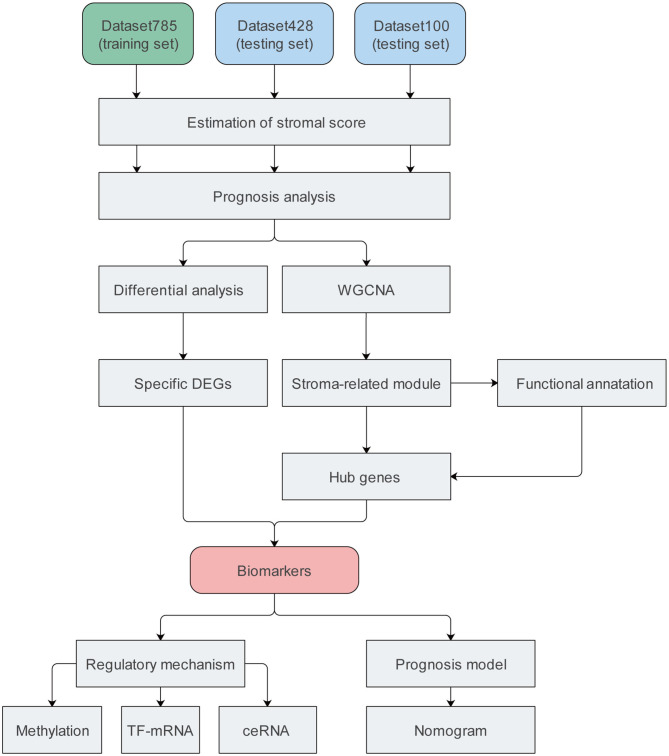
Flow chart of the study. DEG, differentially expressed gene; TF, transcription factor; ceRNA, competing endogenous RNA.